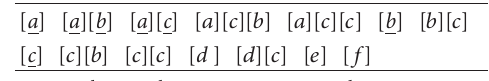
Table 2: All of the frequent patterns extracted from Table 1 at ms3.